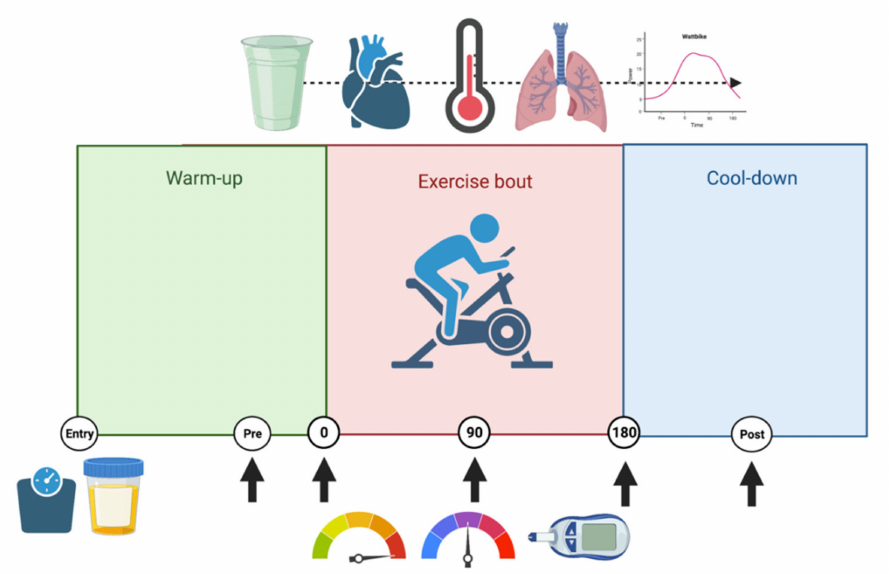
Figure 1. Experimental overview. Circles indicate time points as indicated in Methods and/or Results sections. Mass and hydration were assessed upon entry. The dashed horizontal arrow at the top of the image indicates continuous measurement at the sampling rates mentioned in the appropriate methodological subsections, from the point of menthol mouth-rinsing (green cup). Vertical arrows at the bottom of the image indicate measurement of rating of perceived exertion, thermal comfort and thermal sensation, and blood lactate. Created with Biorender.com (accessed on: 15 March